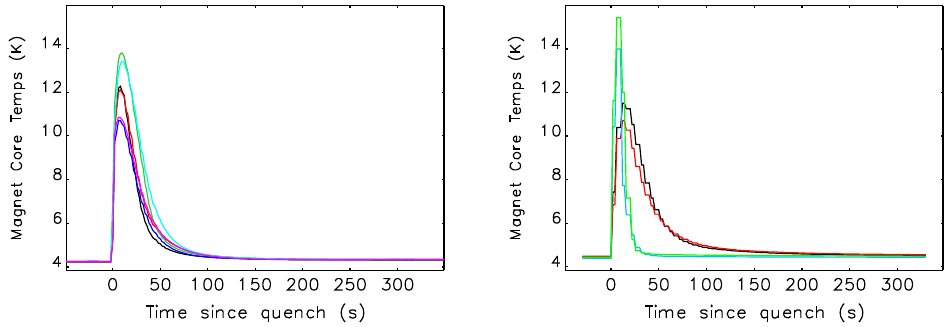
FIG. 16. Magnet core temperatures before and after a quench, measured by six (SCU1, left) and four (SCU0, right) temperature sensors on two magnet cores, shown in different colors. Prior to the quench, the main coil currents were 426 A for SCU1 and 666 A for